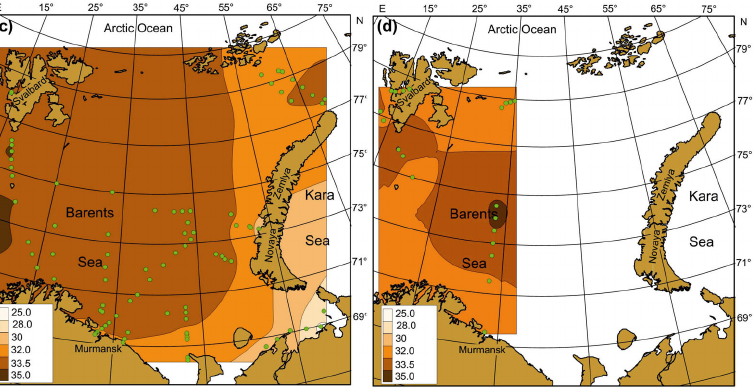
Figure 5. Averaged SSS (psu) in the Barents Sea, 1984–2021. ( a )—spring; ( b )—summer; ( c )—autumn; ( d )—winter. Points indicate the location of sampling stations.